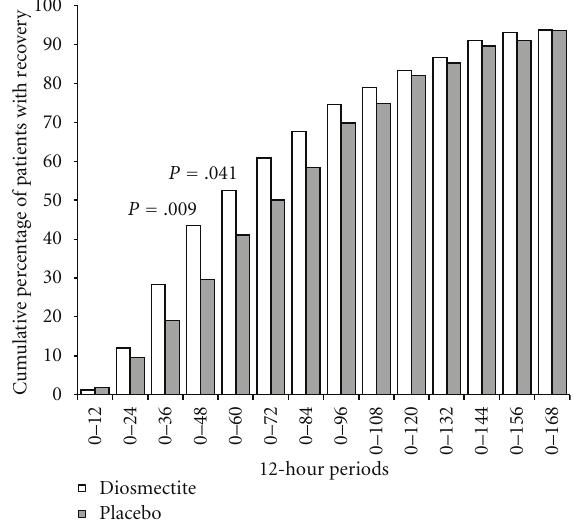
Figure 2: Cumulative percentages of recovered patients per 12h period. Recovery was the first formed stool followed by a nonwatery stool (primary endpoint). Diosmectite (6g three times a day) or placebo in the treatment of acute diarrhoea in